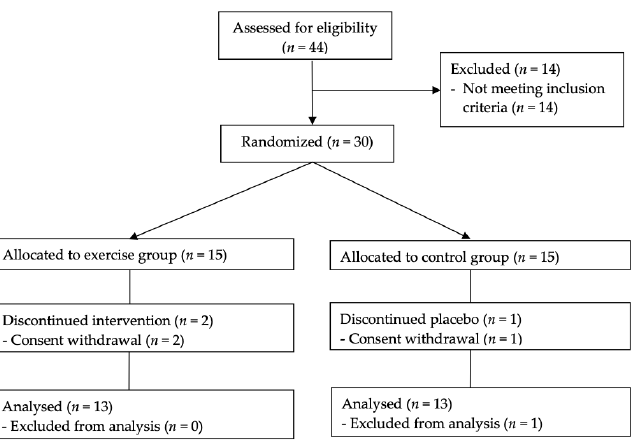
Figure 1. Flow diagram of the study selection process. Of the 44 enrolled candidates, 30 participants were randomised in a 1:1 ratio to either the exercise group or control group.